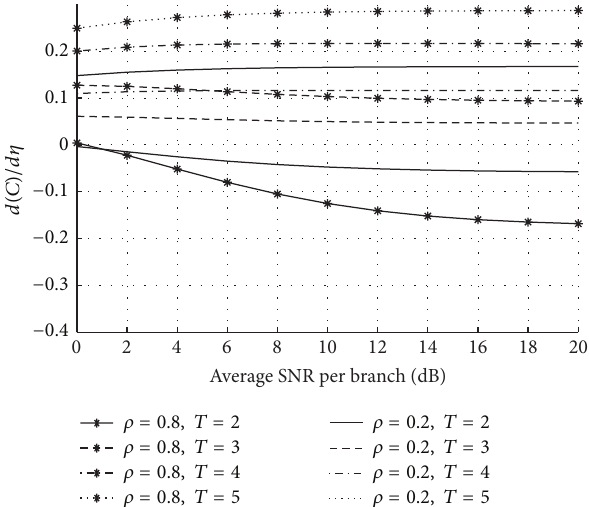
Figure 3: Derivative of ergodic capacity versus average SNR per branch for low correlation ( 𝜌 = 0.2 ) and high correlation ( 𝜌 = 0.8 ). The considered array sizes are 𝑅 = 2 ; 𝑇 = 2, 3, 4,5 .